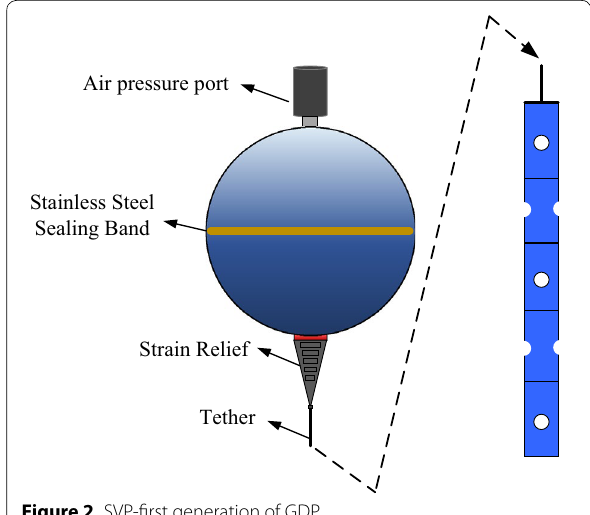
Figure 2 SVP-first generation of